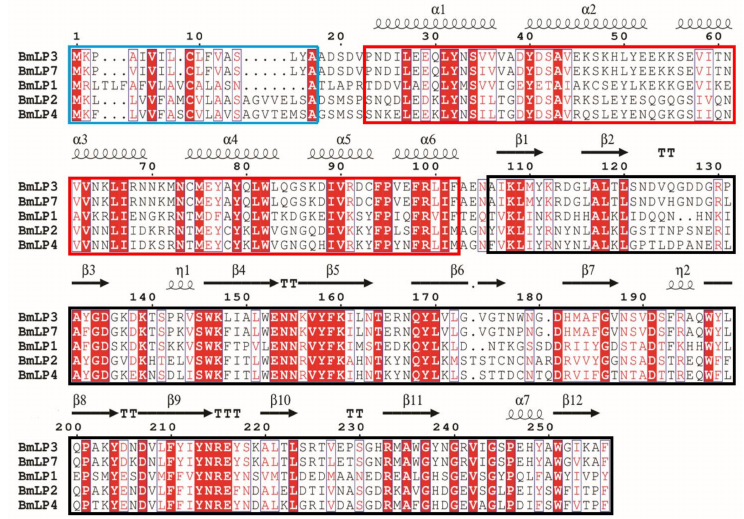
Figure 1. Multiple sequence alignments of five 30K proteins of silkworm. Alignments were Align- ments were performed using ClustalW and ESPript. The second structure elements are indicated above the primary sequences, and the conserved residues are shaded in red, and the signal peptides are marked by blue border. The lipid-binding domains are marked by red border. The ricin domains are marked by black